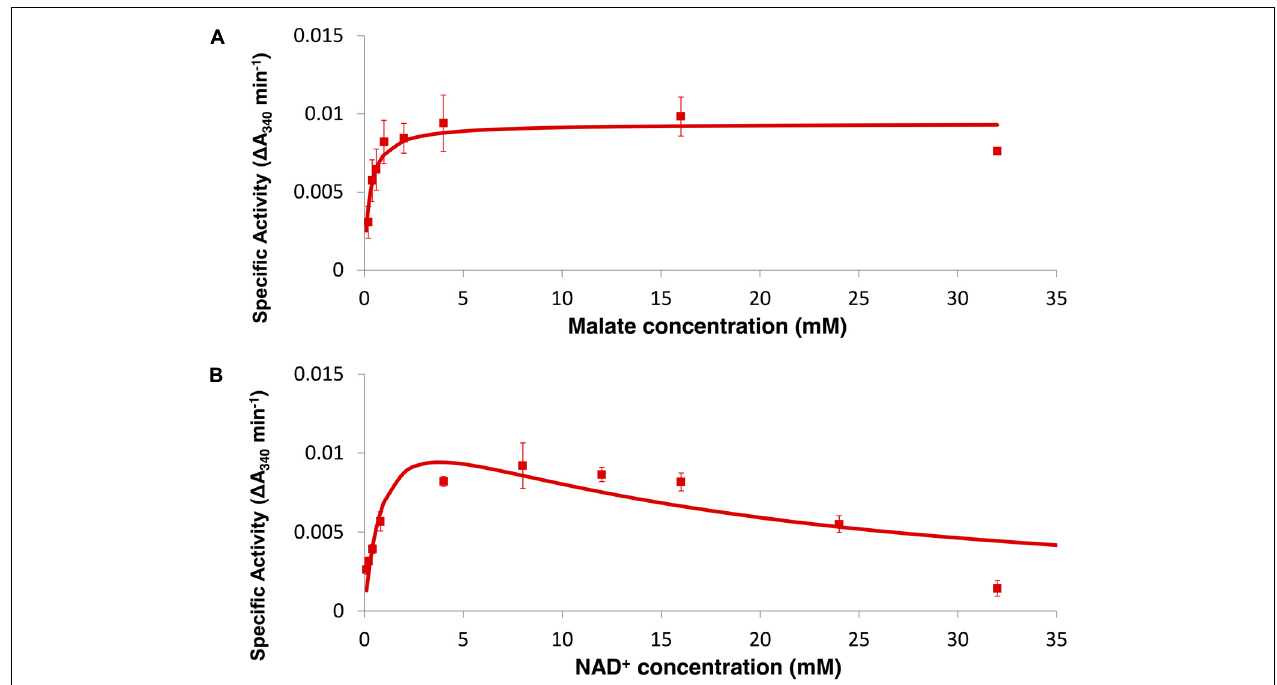
FIGURE 2 | Enzyme assay of Sy MDH in the oxidative reaction in vitro . (A) Activity was measured by varying the malate concentration at a fixed NAD + concentration (8.0 mM). The graphs show the mean ± SD obtained from three independent experiments. (B) Activity was measured by varying the NAD + concentration at a fixed malate concentration (4.0 mM). The graphs show the mean ± SD obtained from three independent experiments.